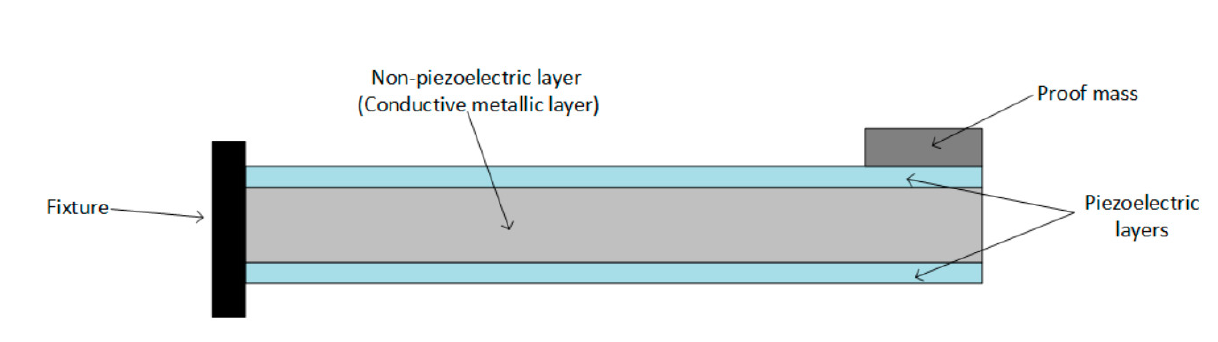
Figure 3. Cantilever Beam Transducer. 1